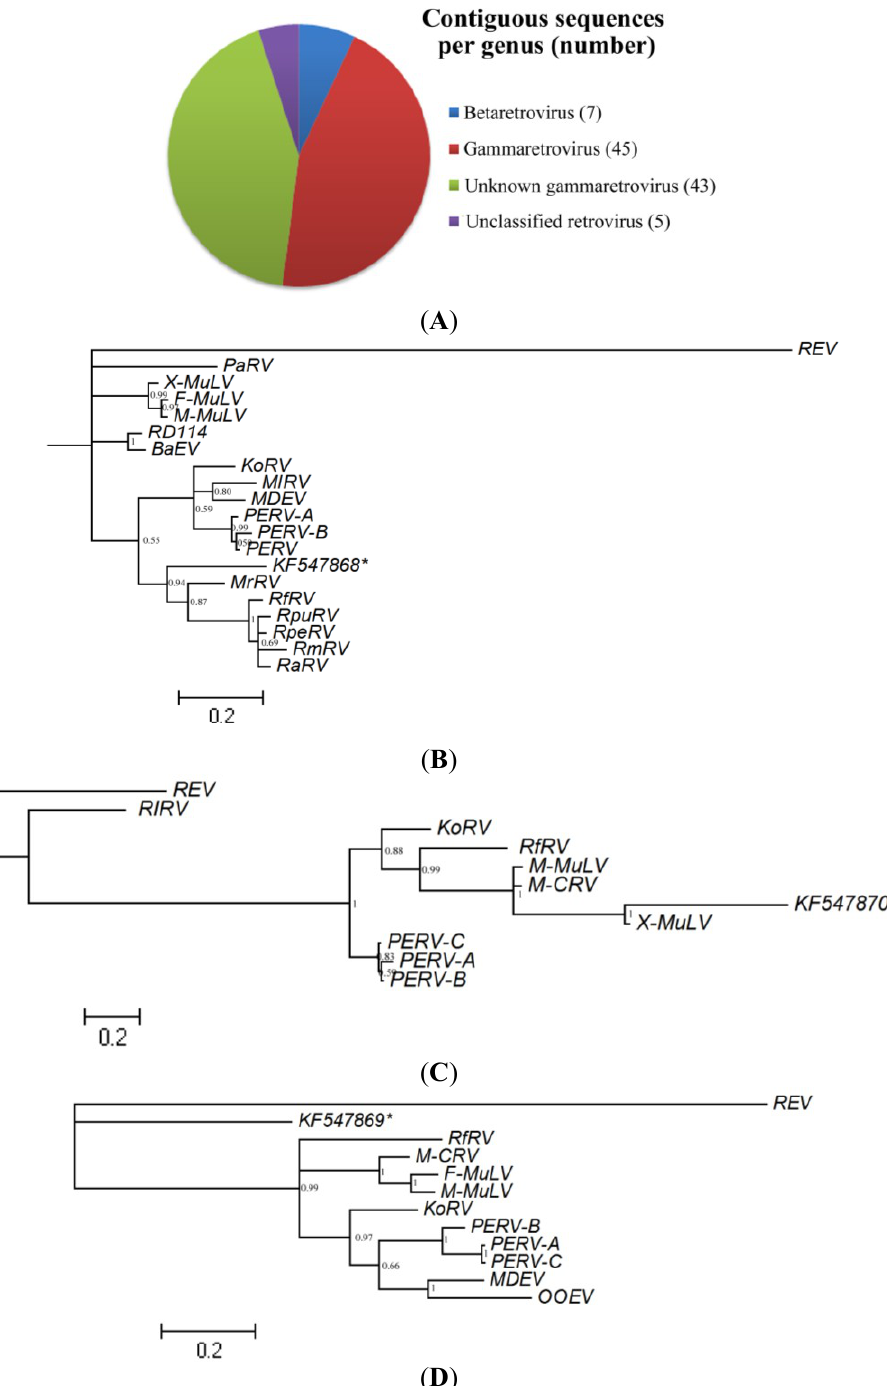
Figure 3. Classification and phylogenetic analysis of retroviral contigs. ( A ) The chart shows proportions of retroviral sequences related to different retroviral genera. The number of sequences related to each genus is shown in parentheses; ( B )–( D ) The midpoint-rooted phylogenetic tree based on alignments of 83 aa Pol (starred), 142 aa Gag (starred) and 150 aa Env (starred) of bat retroviruses, respectively. Posterior probability values are shown at each node and the bar represents the expected number of amino acid substitutions per site. Sequence information is shown in Table